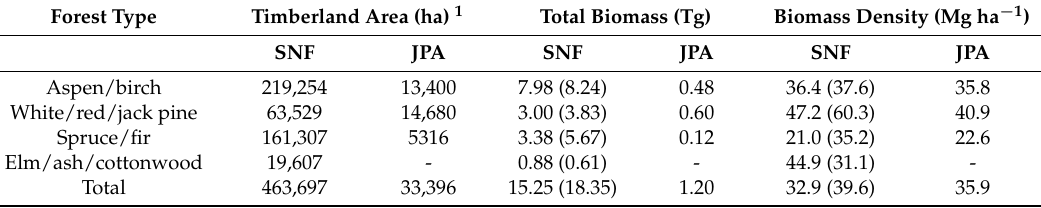
Table 1. Summary of estimated timberland area and current biomass (including bole, tops, and branches) for the four primary forest types in the Superior National Forest (SNF) and Jeanette Project Area (JPA), northeastern Minnesota, USA. Timberland area for SNF and Jeanette based on 435 Forest Inventory and Analysis plots and stand type maps, respectively. Values in parentheses for SNF are biomass estimates obtained from Forest Inventory and Analysis plots using the EVALIDator tool [19].